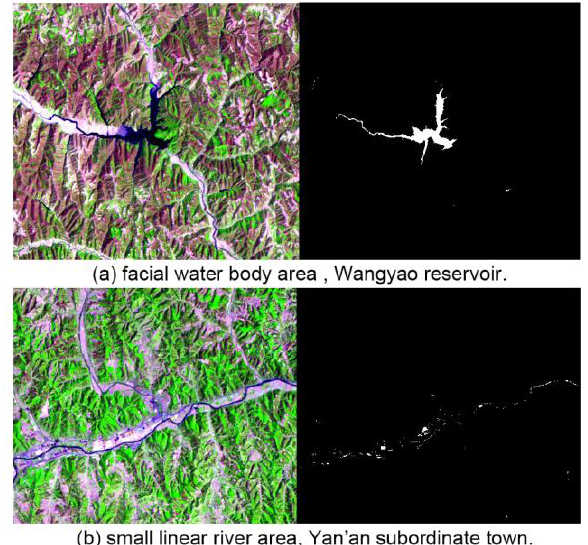
Figure 4. NDWI water extraction results from the study area contrast to the original TM images, displaying the difference in the results of facial water body extraction (a) and small linear river extraction (b).